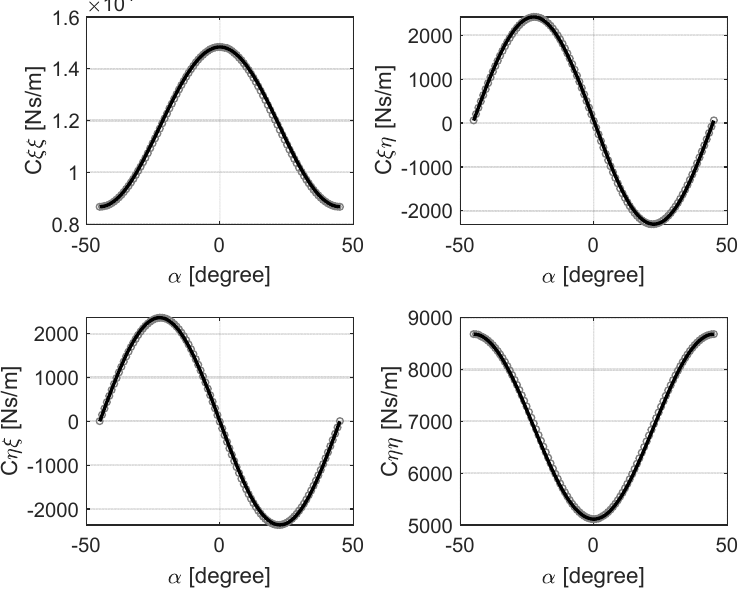
Figure 7. The local damping coefficients of the bearing at 0.5 of relative eccentricity and 1500 rpm. Circles (o) represent the damping coefficients calculated by RAPPID, whereas solid lines represent the damping coefficients calculated according to Equation (2).